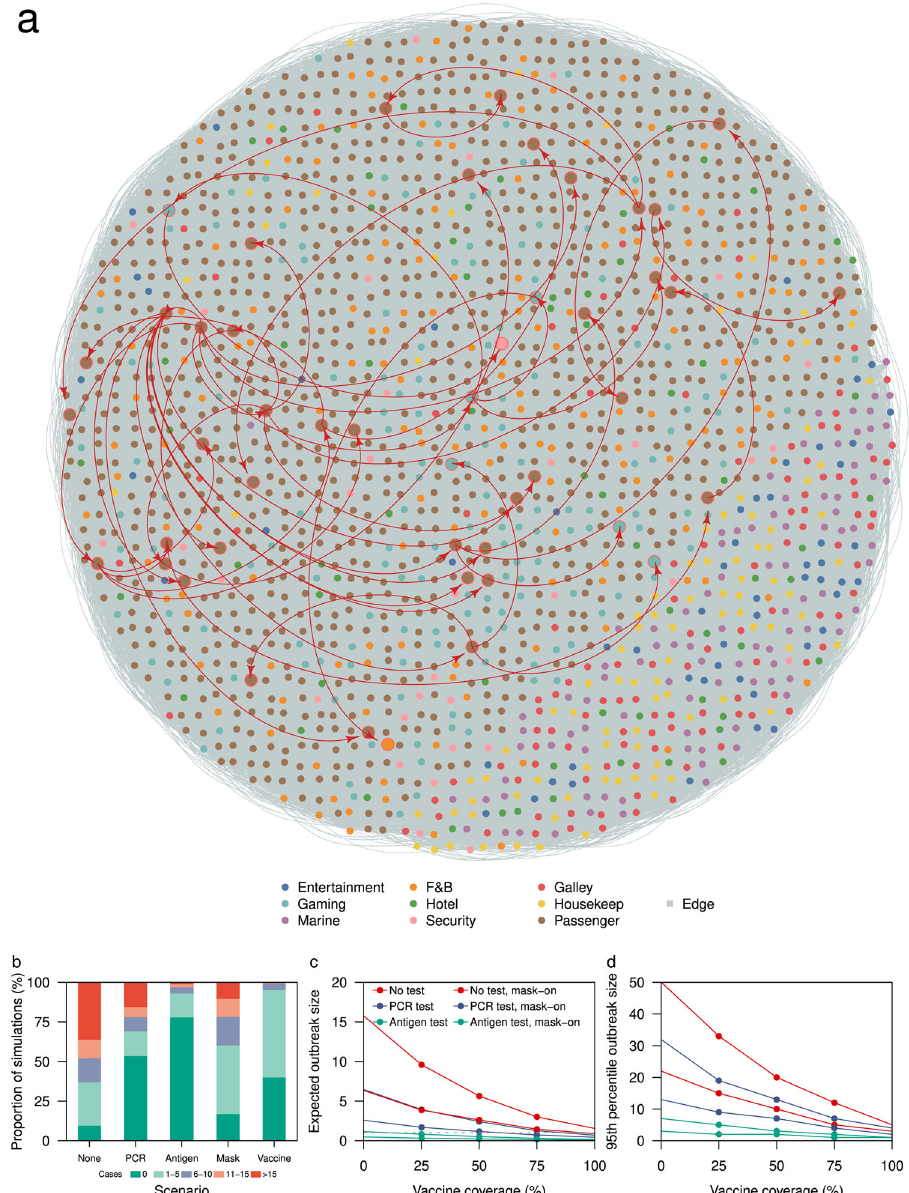
Fig. 4 Outbreak size under respective interventions. a Cases and contacts in one outbreak simulation with cases represented by an enlarged node and red curved arrows depicting disease transmission, b proportion of simulations by respective outbreak size under different interventions, c average outbreak size and d 95th percentile of outbreak size for different interventions and varying vaccination